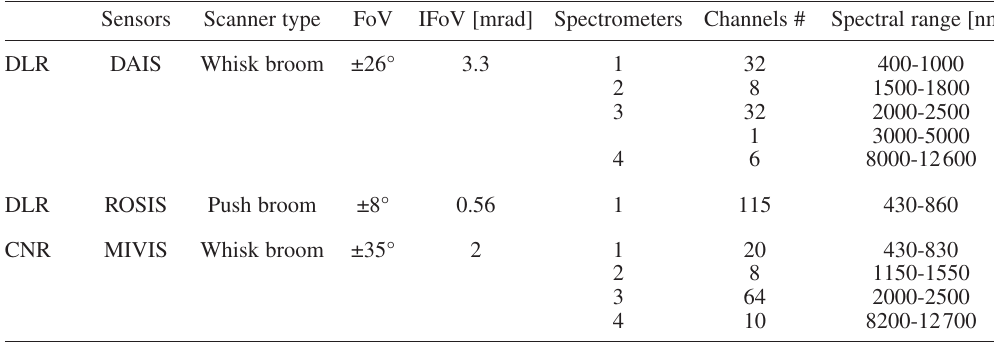
Table I. Spectral and geometric characteristics of different hyperspectral sensors. Flight height was 1800 m de- termining a pixel size for DAIS and MIVIS of about 2.5 m and for ROSIS of 1 m.